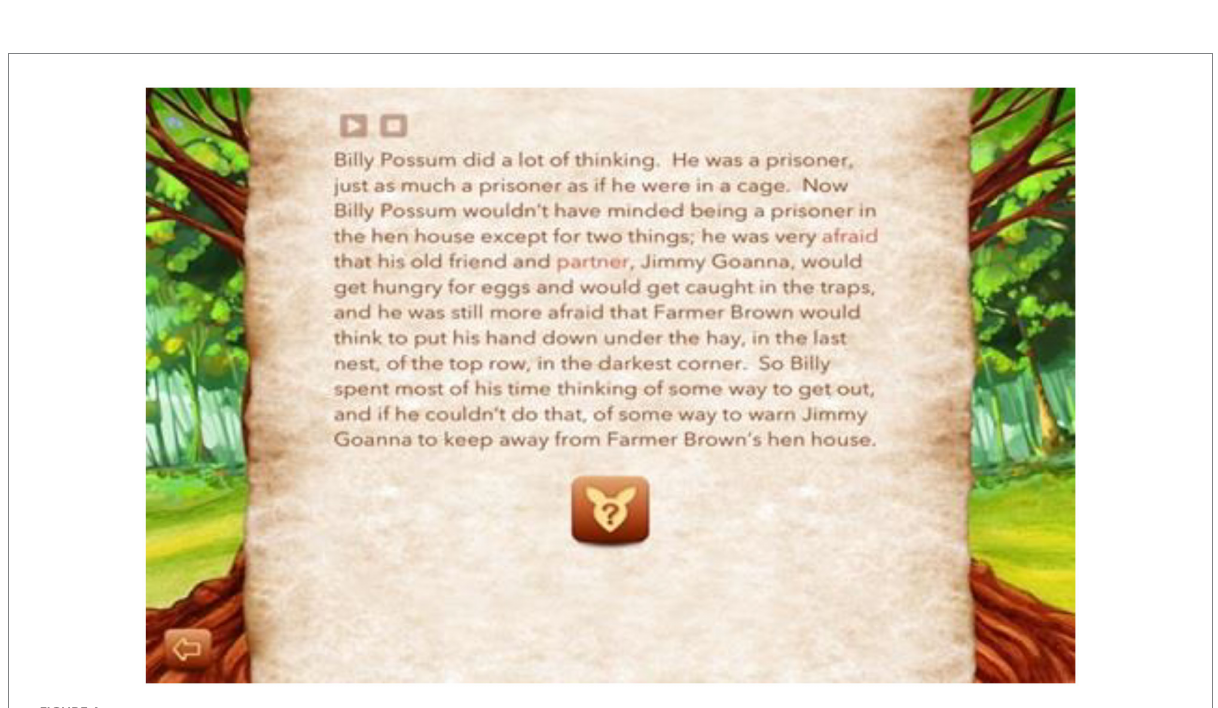
FIGURE 4 Screen shot in app of question strategy